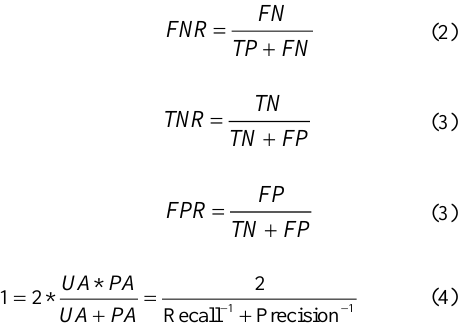
Figure 5 . Visualizing gradient tree decision boosting.